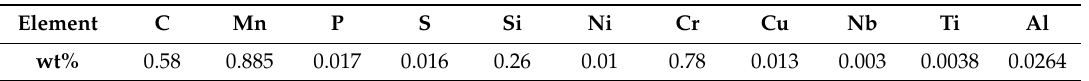
Table 1. Chemical composition of the studied